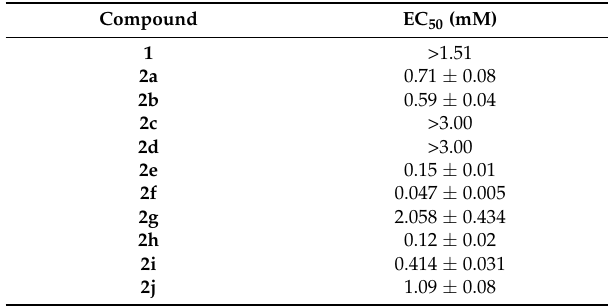
Table 4. Effect of the substrates on the mycelial growth of B. cinerea in solid